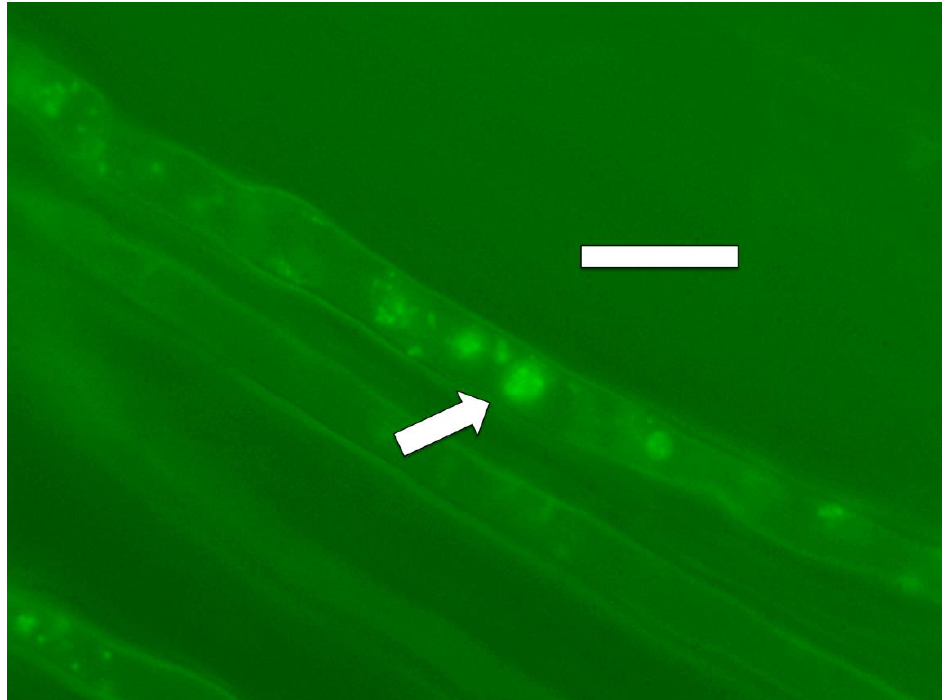
Figure 10. Poa reptans seedling root hair showing nitric oxide (green fluorescence; arrow) staining around cells of bacterium Bacillus amyloliquefaciens stained with diaminofluorescein (DAF; bar = 30 µm).